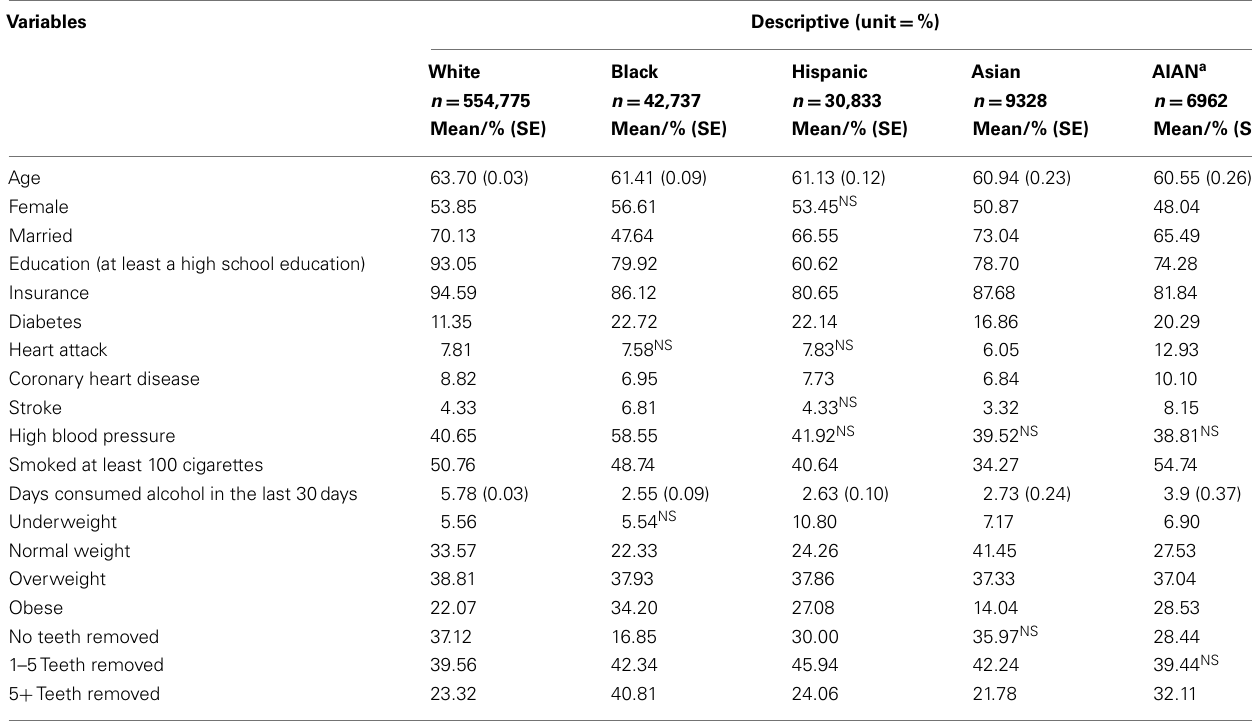
Table 1 | Sample characteristics by